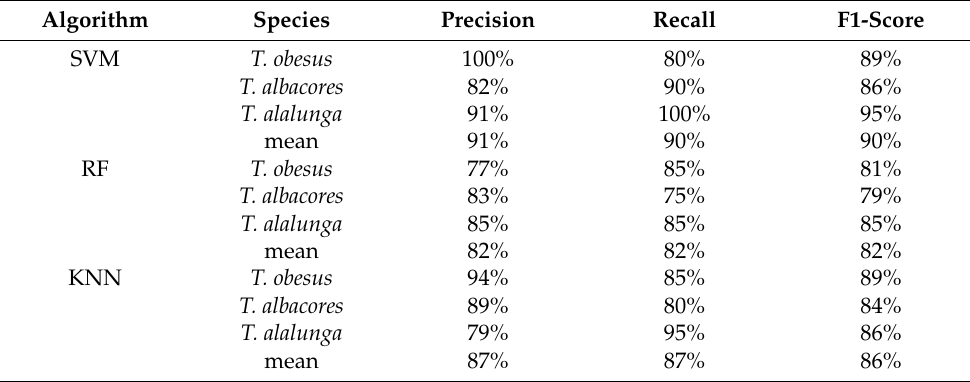
Table 4. Values of performance evaluation metrics obtained using deep